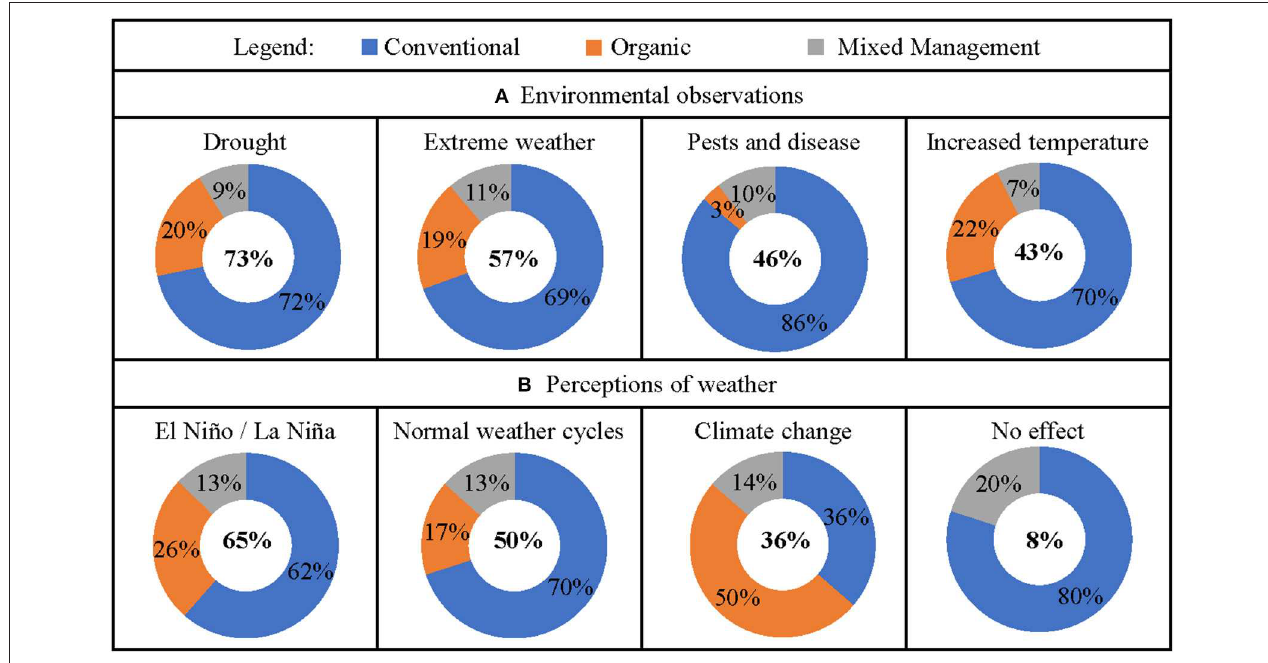
FIGURE 7 | Environmental observations and perceptions of weather. (A) Total percentage (center) and the proportion of conventional, organic, and mixed management producers that reported environmental observations ( n = 63) that have impacted lentil production including drought, extreme weather, pests and disease ( p = 0.002), and increased temperature. (B) Total percentage (center) and the proportion of conventional, organic, and mixed management producers that reported effects of weather ( n = 60) that have had an impact on their agricultural business including the cyclical weather patterns El Niño and/or La Niña, normal weather cycles and variation, climate change ( p = 0.0012), and no effect of weather variation or extremes on their agricultural business.